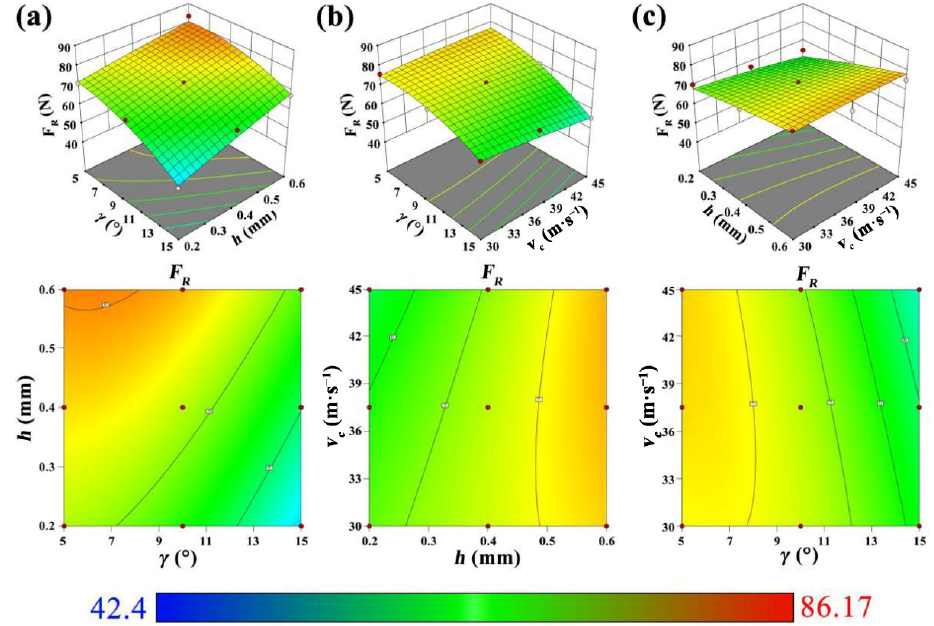
Figure 3. Two-level interactions on resultant force: ( a ) rake angle and depth of cut ( b ) rake angle and cutting speed and ( c ) cutting speed and depth of cut.